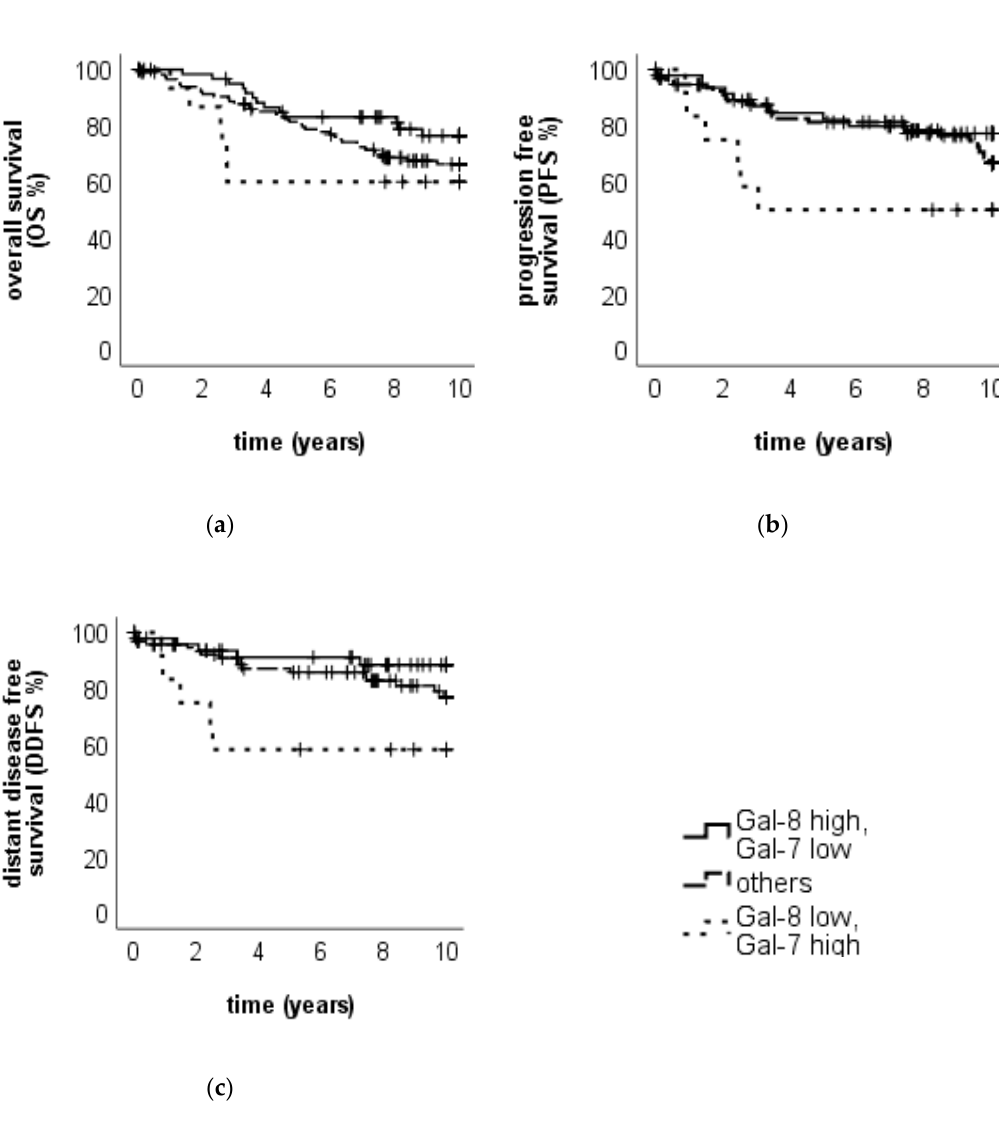
Figure 7. OS, PFS and DDFS for the two groups. Kaplan–Meier analysis of OS ( a ), PFS ( b ) and DDFS ( c ) in tumors with combined high or low Gal-7 expression with low or high Gal-8 expression (in the cytoplasm), respectively, are shown. Tumors with high Gal-7 and low Gal-8 expression in the cytoplasm show the trend of an impaired OS, while tumors with high Gal-8 and low Gal 7 expression show the trend of an improved OS. Tumors with high Gal-7 and low Gal-8 expression in the cytoplasm show the trend of an impaired PFS and a significantly reduced DDFS, while tumors with high Gal-8 and low Gal-7 expression show the trend of an improved PFS and a DDFS.